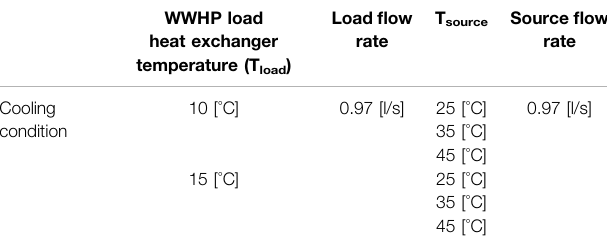
TABLE 5 | Water-to-water heat pump performance lab test